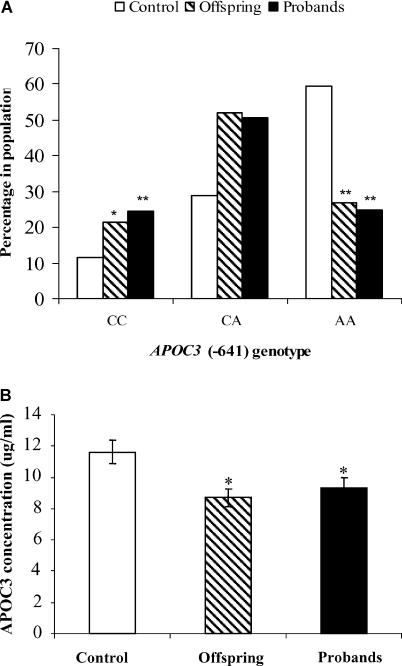
Genotype Distribution of
APOC3 C(−641)A and Serum APOC3 Concentrations
(A)
APOC3 C(−641)A.
(B) Serum APOC3.*
p < 0.05, **
p = 0.001 versus control.
CC, homozygous for (−641) C; AA, homozygous for (−641) A; CA, heterozygous for (−641) C/A.